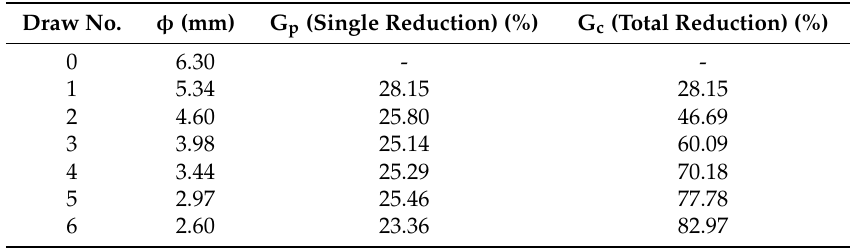
Table 3. Scheme of applied single drawing reductions and the total drawing reduction in the drawing process involving TRIP steel wire rod, in a system with high single reductions. Draw No.